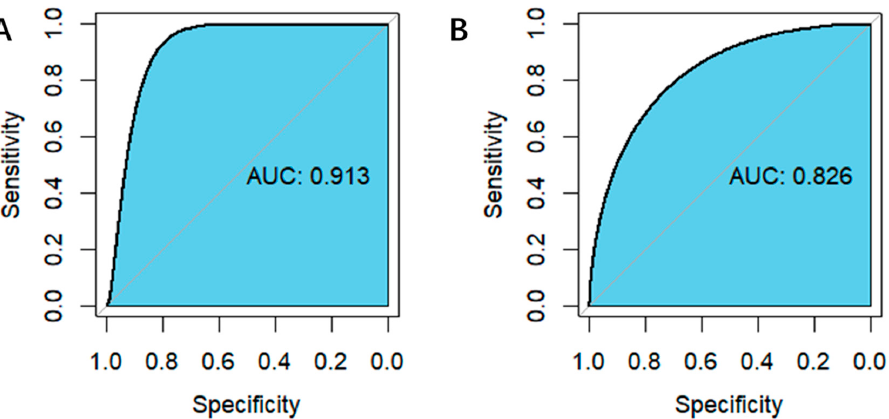
Figure 3. Receiver operating characteristic (ROC) curve and the area under the ROC curve (AUC). Specificity represents the proportion of the negative samples that were correctly classified, and sensitivity is the proportion of the positive samples that were correctly classified. AUC value is equivalent to the probability that a randomly chosen positive example is ranked higher than a randomly chosen negative example. The closer the ROC curve reaches the top left corner and the closer the AUC value is to 1, the better the classifier is. ( A ) 1:1 mixed sample. ( B ) 1:10 mixed sample. To test the specificity of the methods, we also used 80 samples that did not contain the target species ( C. auris or C. krusei ). Among them, there were 50 samples of pure cultured strains and 30 samples of 1:1 mixtures of two species. For the samples of pure cultured strains, the Bruker Biotyper correctly identified 98% of the samples (49/50). For the 30 mixed samples, although the Bruker Biotyper did not mistakenly identify samples as containing the target species, it did not effectively identify the species in the samples. Correspondingly, the modified naïve Bayesian classifier excluded 94% of the pure culture strains and 90% of the mixed